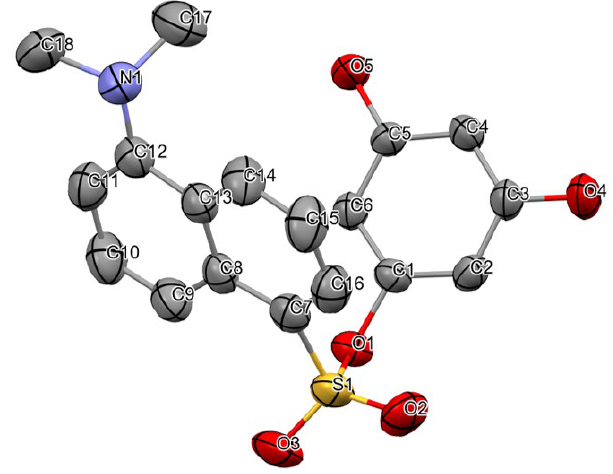
Figure 1. Molecular structure of sensor R1 drawn with 50% thermal ellipsoid probability. Hydrogen atoms have been omitted for clarity.